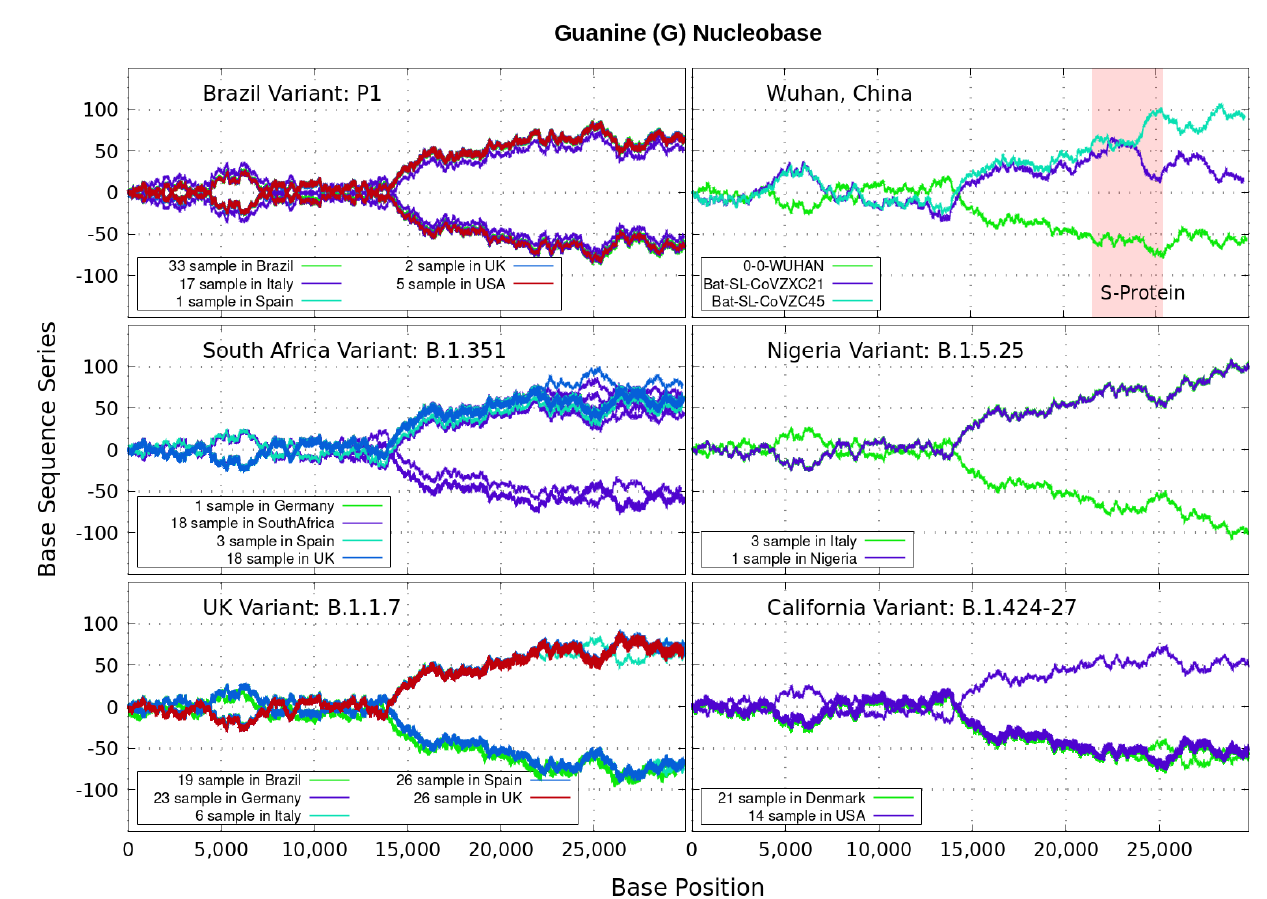
Figure 6. Variant imprints displayed by the nucleotide base: